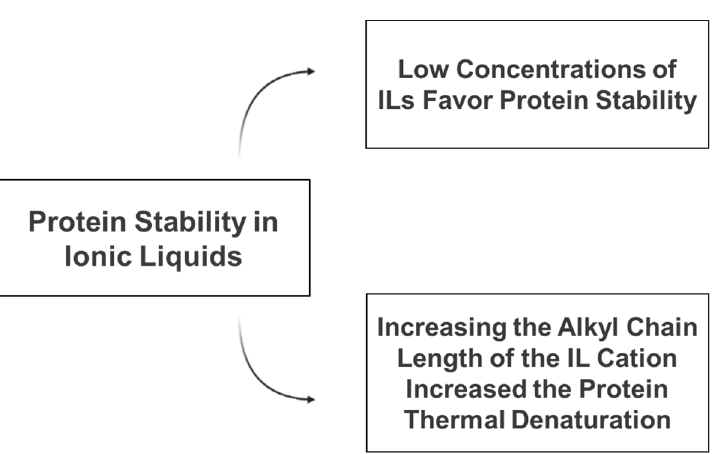
Figure 3. Main factors affecting the stability of proteins in the presence of ionic liquids.